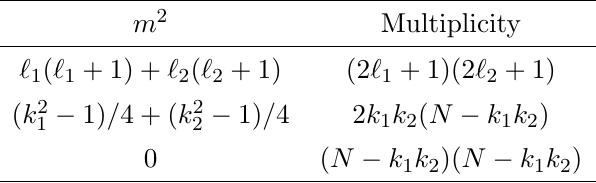
Table 1 . Masses for the easy bosons A 0 , A 1 and A 2 (as well as the ghosts c ), including the k 1 k 2 (cid:2) k 1 k 2 , the k 1 k 2 (cid:2) ( N (cid:0) k 1 k 2 ) and the ( N (cid:0) k 1 k 2 ) (cid:2) ( N (cid:0) k 1 k 2 ) blocks. Here ‘ 1 = 0 ; : : : ; k 1 (cid:0) 1 and ‘ 2 = 0 ; : : : ; k 2 (cid:0)